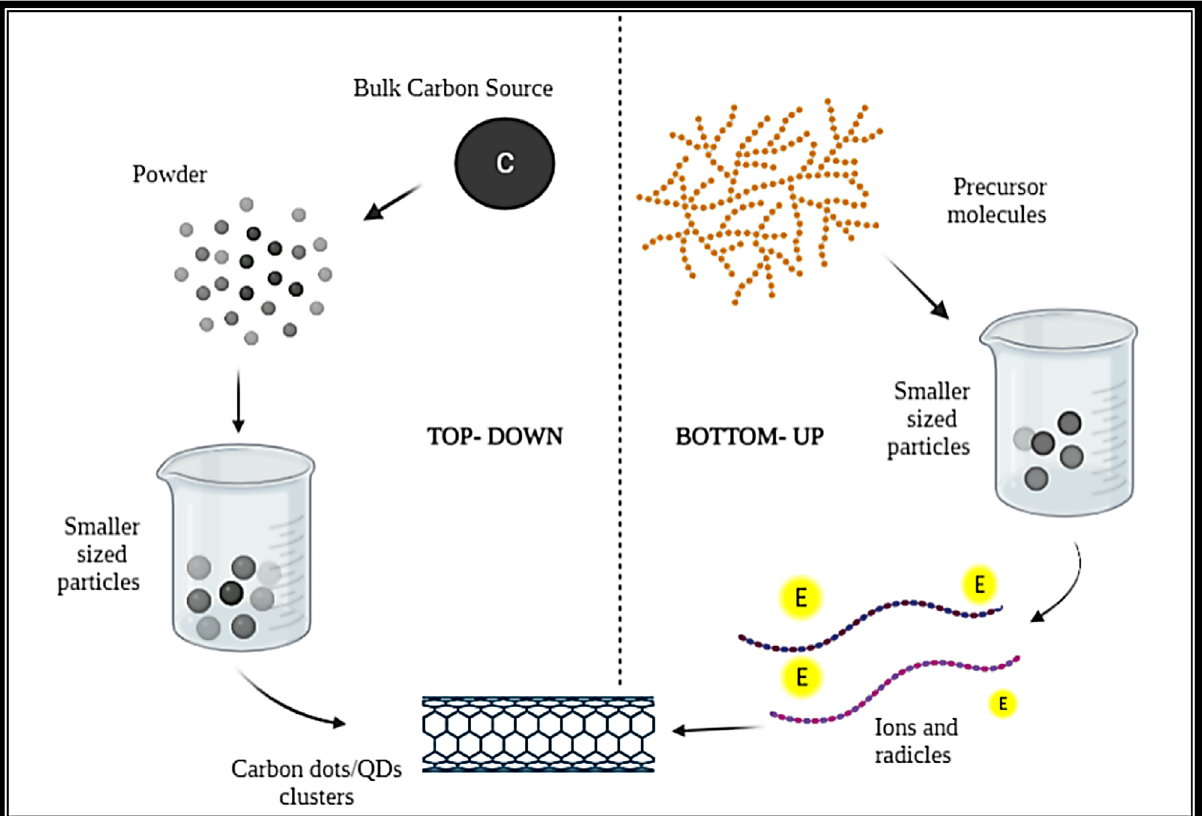
Figure 2. Top-down and bottom-up approach